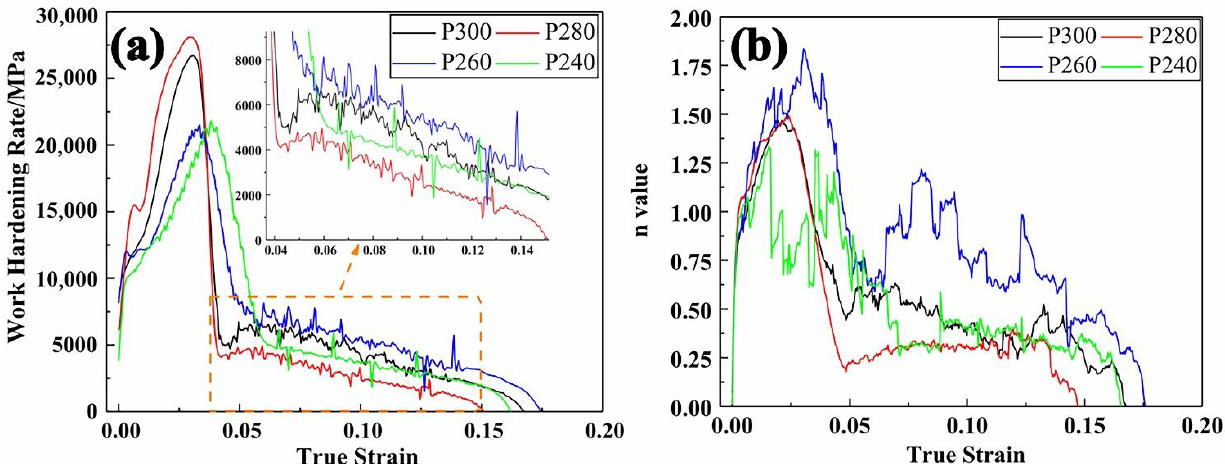
Figure 7. Work-hardening behavior of test steels at different partition temperatures: ( a ) work-hardening rate curve; ( b ) instantaneous strain-hardening exponent ( n value).